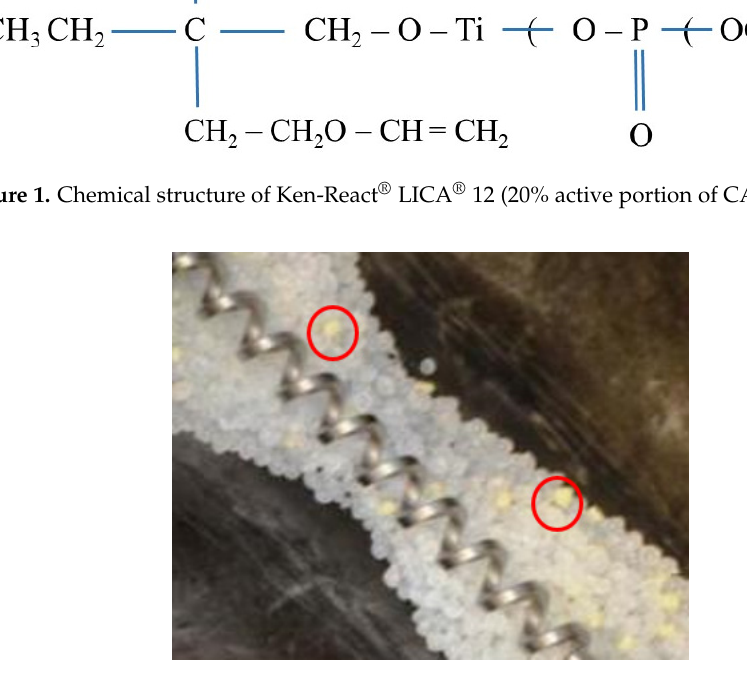
Figure 3. Extruder screw design.